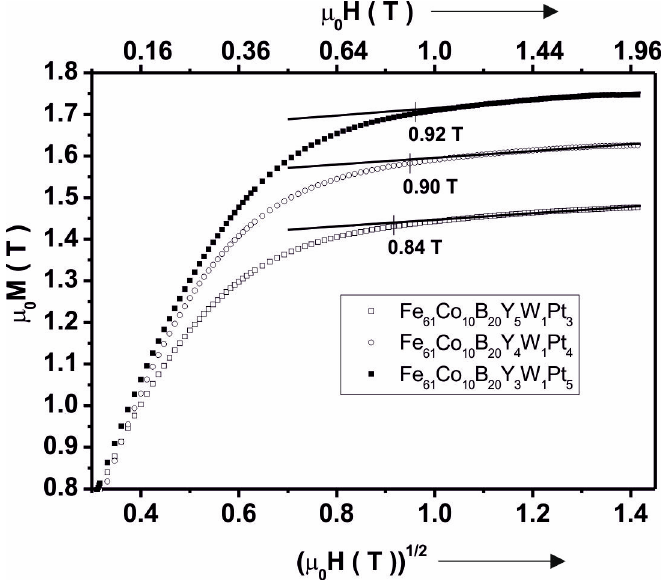
Figure 8. Magnetic saturation ( μ 0 M s ) of the alloys, in the as-cast state, as a function of ( μ 0 H ) 1/2 .